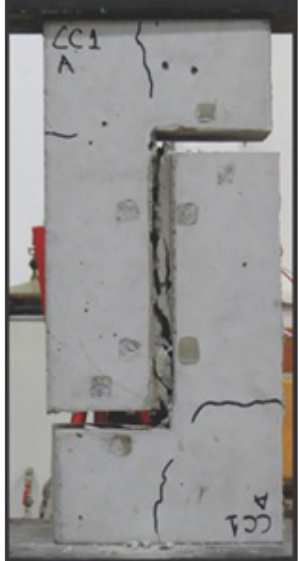
Figure 6. Rupture of specimen